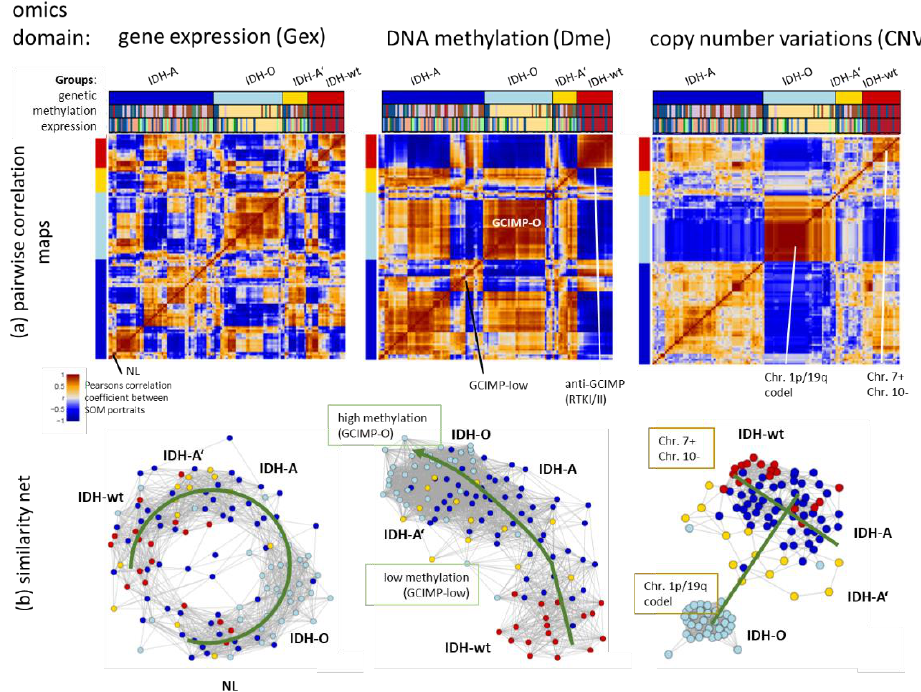
Figure 3. Similarity analysis of LGG using Gex, Dme and CNV data using pairwise similarity provides heatmaps of the SOM portraits (part ( a )) and similarity network presentation (part ( b )) (each circle indicates one tumour). CNV shows the clearest separation between genetic groups mainly along two axes referring to the Chr. 1p/19q codeletion and Chr. 7 + status, followed by Dme distributing the tumours along one axis according to their methylation level. Gex produces more diverse, multidimensional patterns resembling a closed circular net with strong intermixing of IDH-A, IDH-A and IDH-wt tumours. For methods description, see Appendix B.